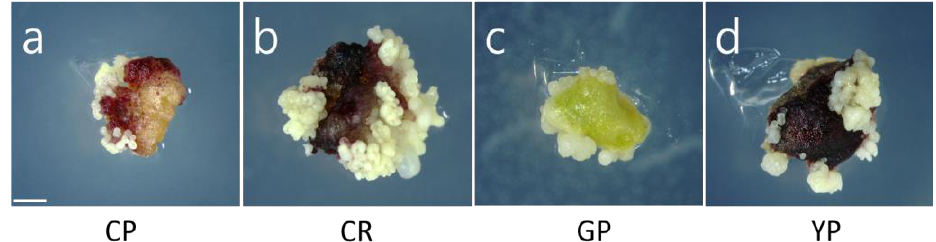
Figure 4. Morphological characteristics of explants containing somatic embryos depending on the cultivar of P. ginseng. Photographs were taken 60 days after culturing in the induction media. ( a ) Chunpoong, ( b ) Cheonryang, ( c ) Gumpoong, and ( d ) Yunpoong. Scale bars, 1 mm. CP, Chunpoong CR, Cheonryang GP, Gumpoong YP, Yunpoong.